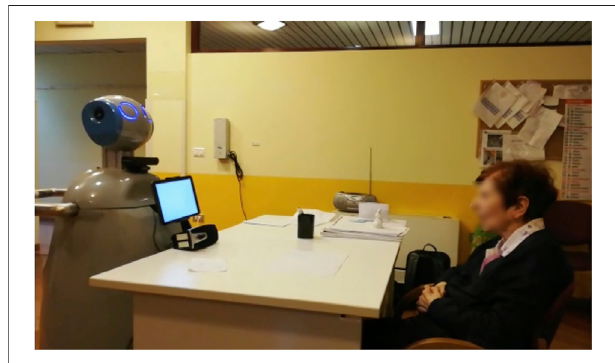
FIGURE 3 | Experimental set-up: ASTRO robot is administering the MMSE test to the